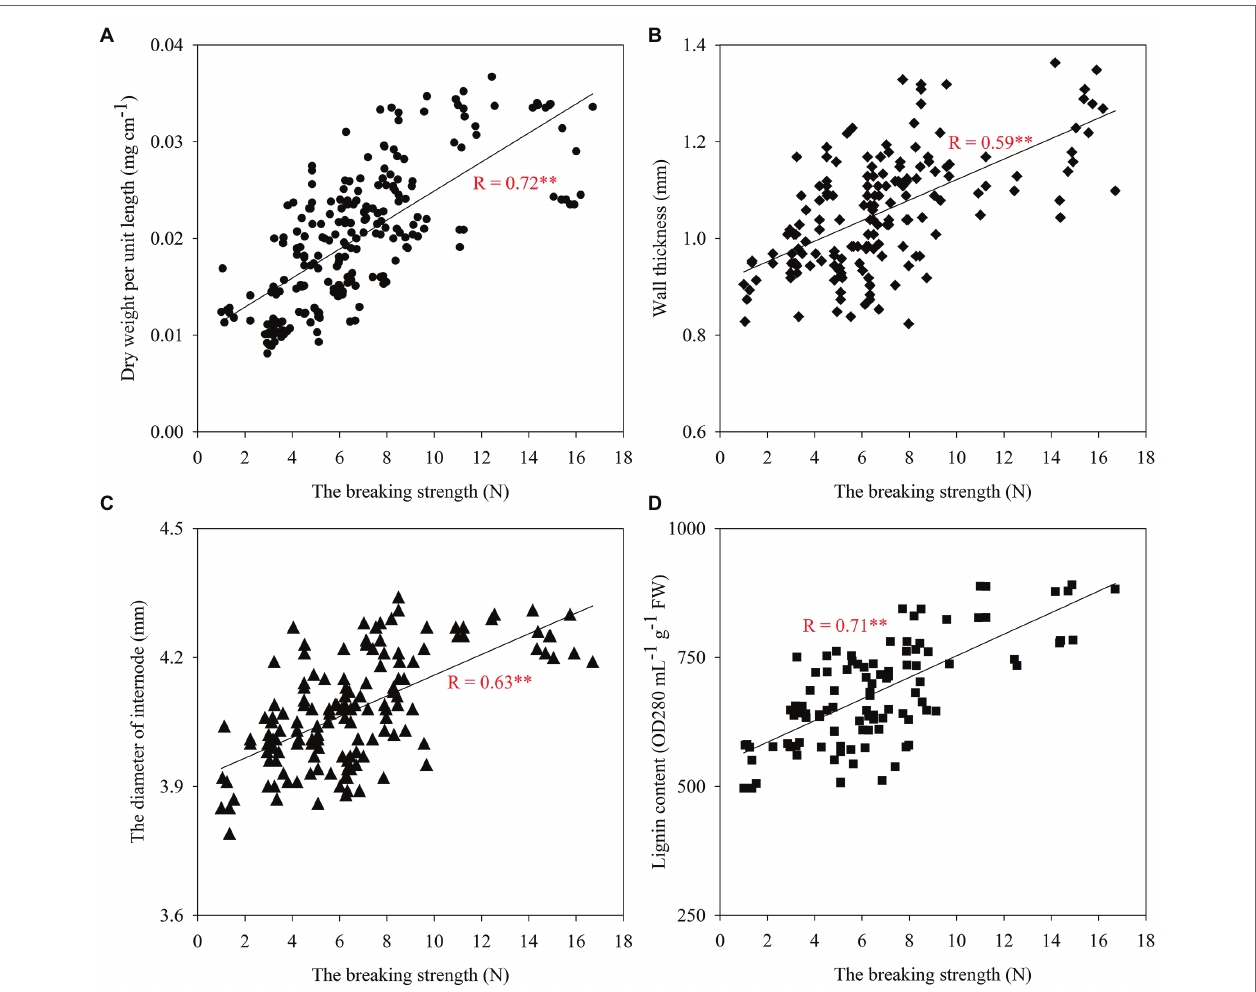
FIGURE 8 | Correlation analysis between breaking strength and the dry weight per unit length (A) , the wall thickness (B) , the diameter of internode (C) , and the lignin content (D) of the second basal internode. Correlation coefficients (r) are calculated. Asterisks ( * ) represent significance at the 0.05 probability level ( A : n = 234, B : n = 168, C : n = 144, and D : n = 108).